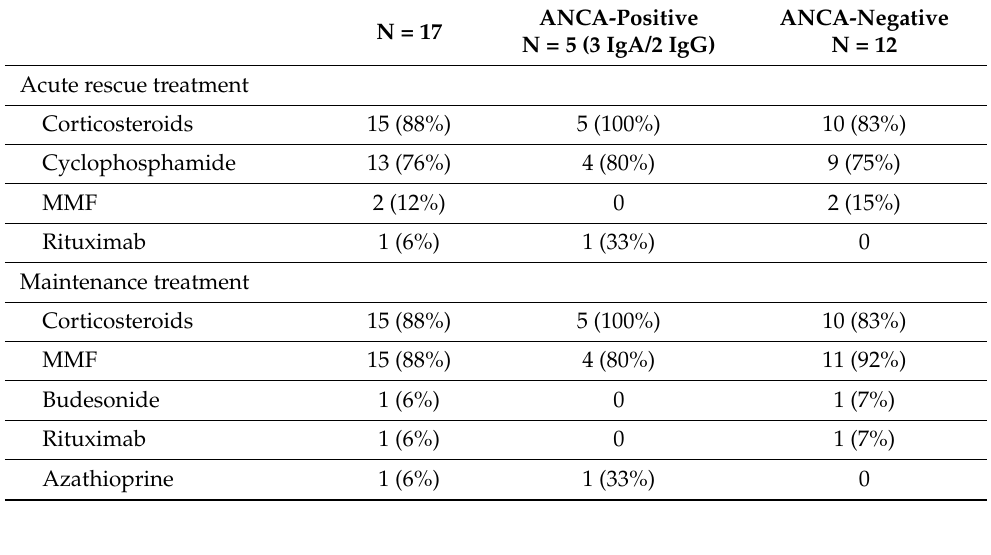
Table 4. Immunosuppressive therapy in patients with crescentic IgA nephropathy according to the presence or absence of ANCAs.